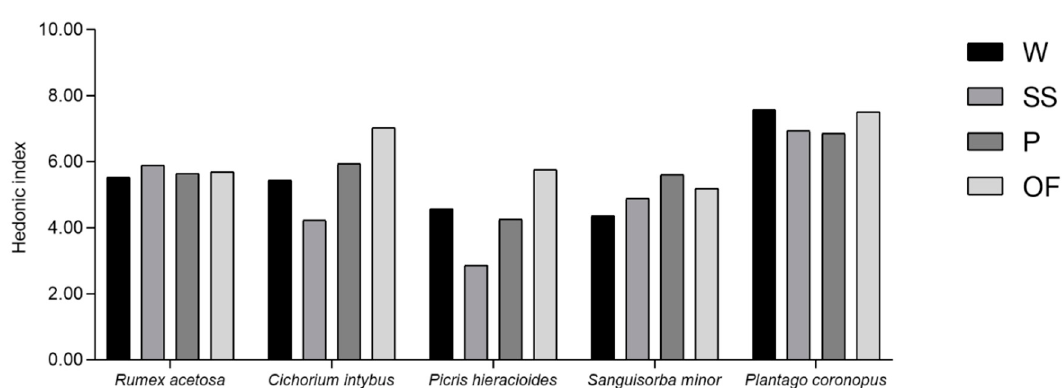
Figure 5. Hedonic index of Rumex acetosa , Cichorium intybus , Picris hieracioides , Sanguisorba minor , and Plantago coronopus wild-collected (W) and cultivated according to three different techniques: “soilless” (SS), pot (P), and open field (OF).